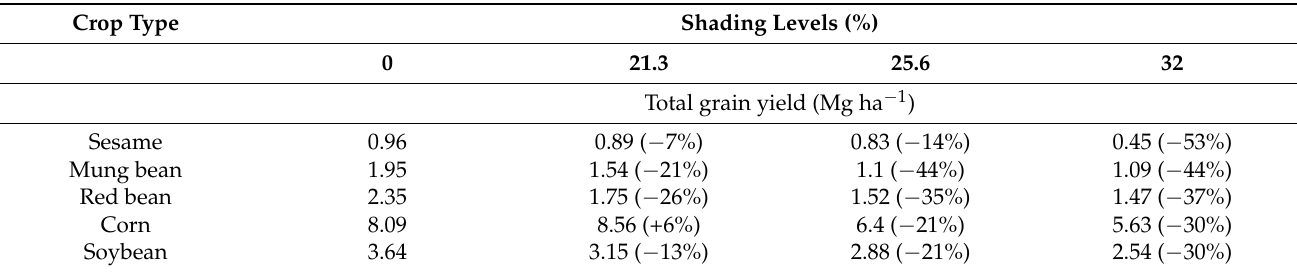
Table 6. Harvested grain yields of all five crops grown under four different shading levels (0, 21.3, 25.6, and 32%). The numbers in parentheses indicate loss ( − ) or gain (+) in yield compared to the yield without shading. Crop Type Shading Levels (%) 0 21.3 25.6 32